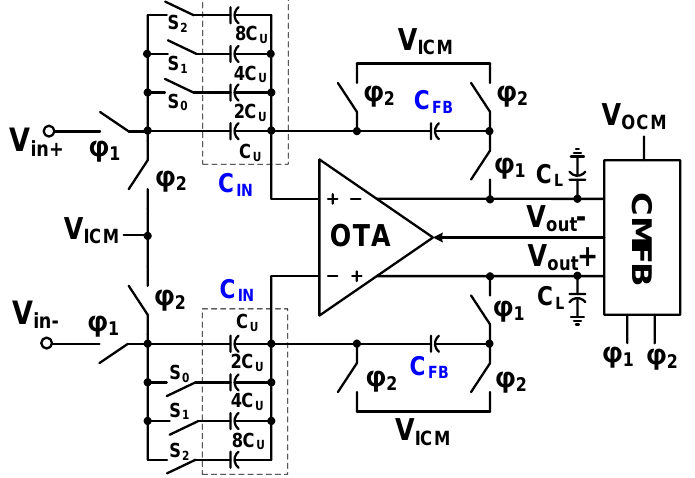
Figure 13. Schematic of the instrumentation amplifier.